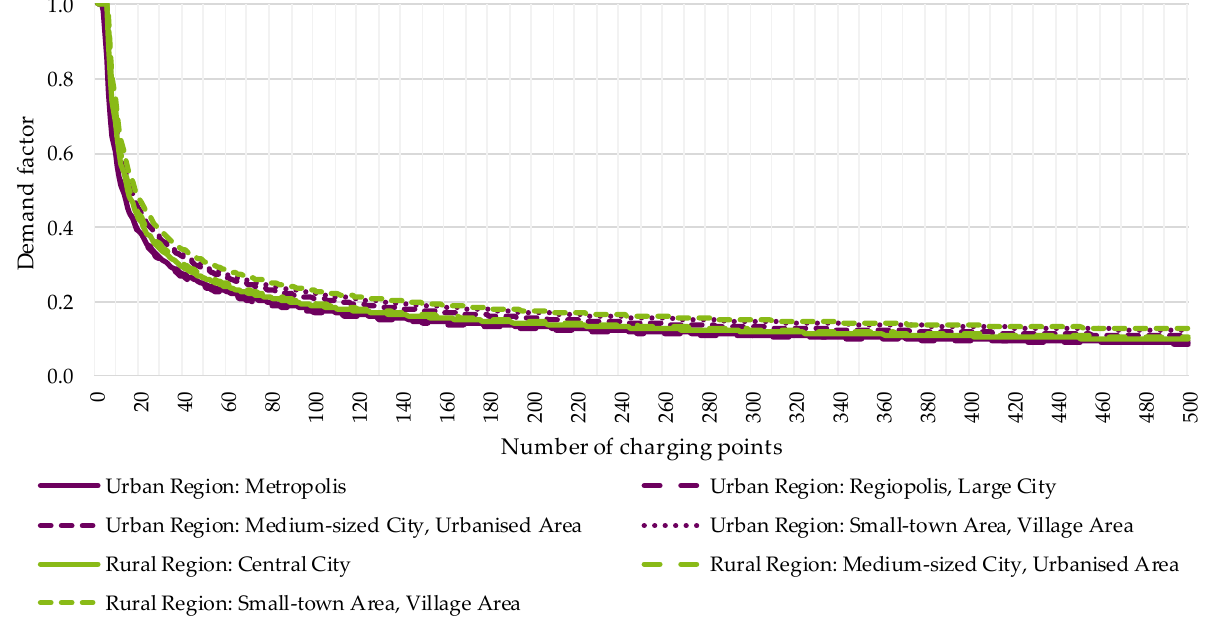
Figure 22. Demand factors (ordinate) for 11 kW charging power and seven different area types.